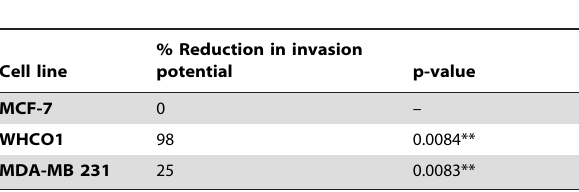
Table 3. IgG1-iS18 reduces invasive potential of breast and oesophageal cancer